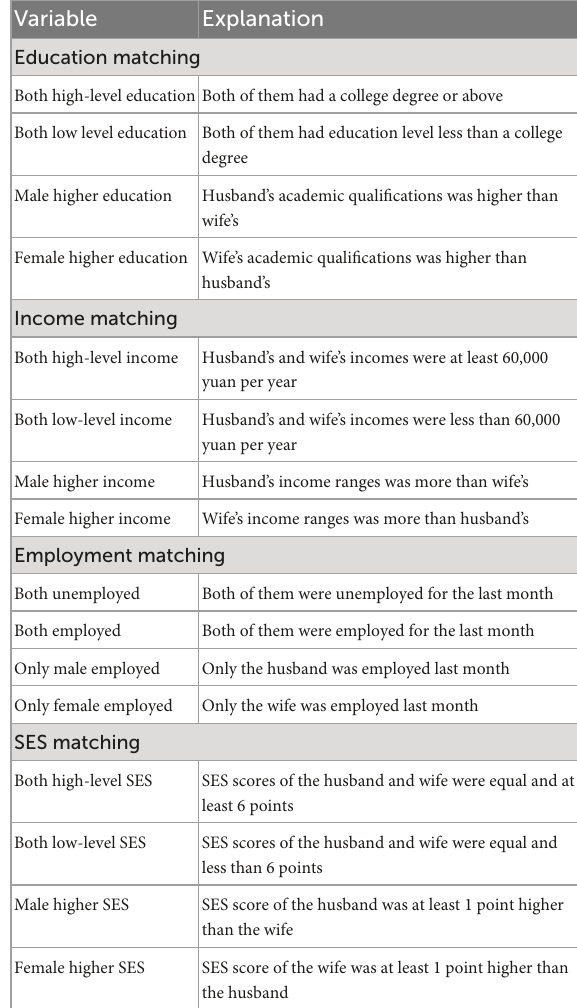
TABLE 1 Indicators for SES matching in